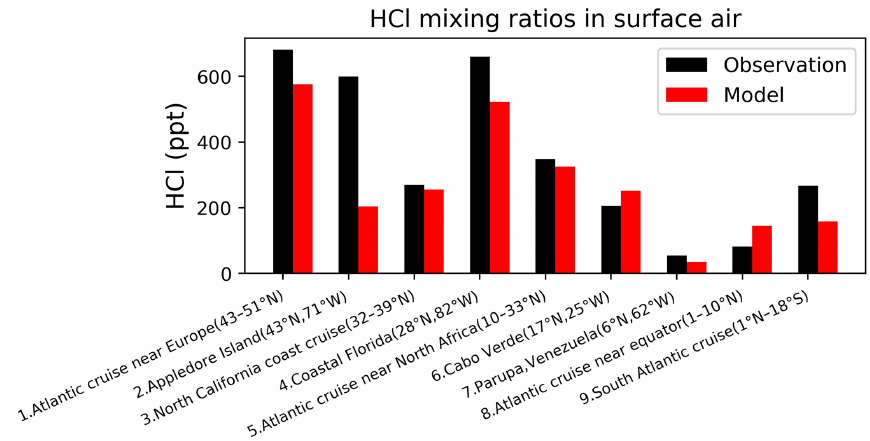
Figure 7. Surface air mixing ratios of HCl at coastal and island sites and from ocean cruises, arranged from left to right in order of decreasing latitude. Observations (black) are means or medians depending on availability from the publications. Model values (red) are monthly mean values in 2016 taken for the same month and location as the observations. References: (1, 5, 8, 9) Keene et al. (2009), (2) Keene et al. (2007),